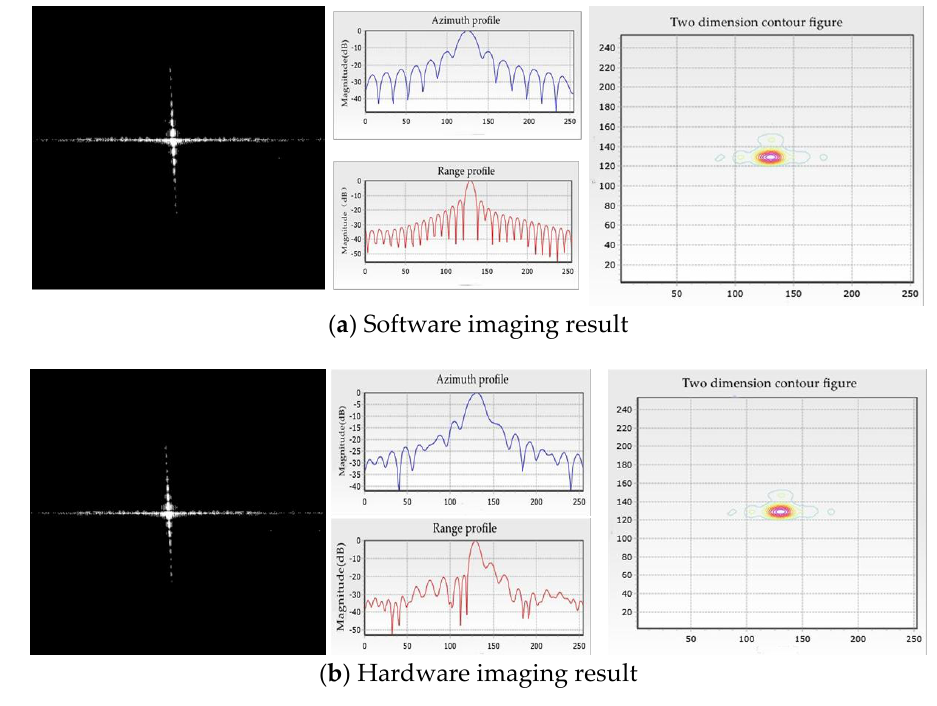
Figure 6. Point target imaging result with no window. Table 1. Point target imaging quality assessment.